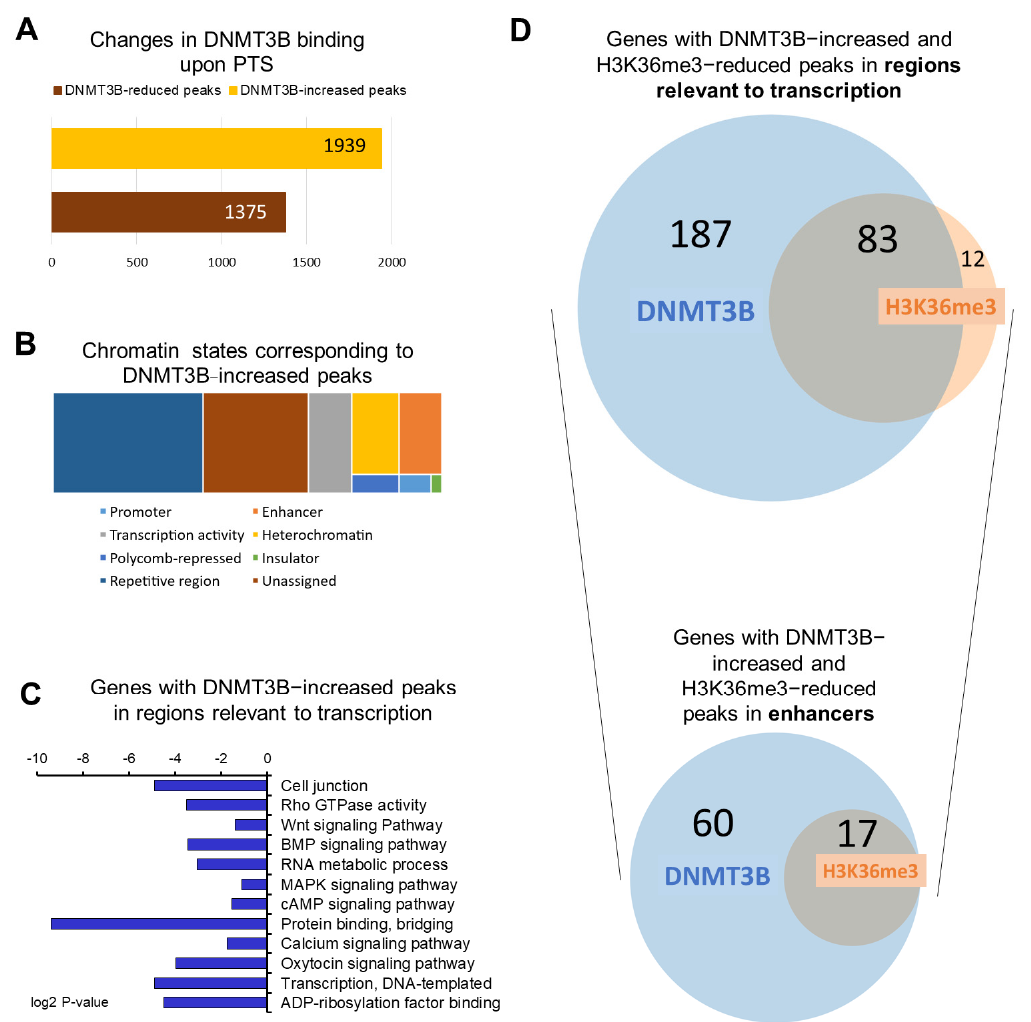
Figure 1. Overview of genome − wide changes of DNMT3B binding in response to PTS. ( A ) A bar chart depicting the number of changes in DNMT3B binding in MCF10CA1a breast cancer cells treated with 7 µ M PTS for 9 days. DNMT3B binding was assessed by ChIP sequencing. ( B ) Chromatin states associated with DNMT3B-increased peaks were determined using Broad ChromHMM data from human mammary epithelial cells (HMEC) available on USCS Genome Browser (hg19). Peaks could correspond to active, weak, or poised promoters, strong or weak enhancers, putative insulators, active or weak transcription, Polycomb − repressed regions, heterochromatin, or repetitive regions. ( C ) The 270 genes with DNMT3B-increased peaks in regions relevant to transcription upon PTS (i.e., promoters, enhancers, insulators, Polycomb- repressed regions, or heterochromatin) were subjected to Gene Ontology (GO) function and Kyoto Encyclopedia of Genes and Genomes (KEGG) pathway analysis using DAVID Knowledgebase. ( D ) Venn diagrams present an overlap between genes with DNMT3B − increased and H3K36me3-reduced peaks that were located in regions relevant to transcription and specifically in enhancer regions. The proportionally scaled Venn diagrams were generated using tools on www.stef- anjol.nl/venny (accessed on 28 May 2021).